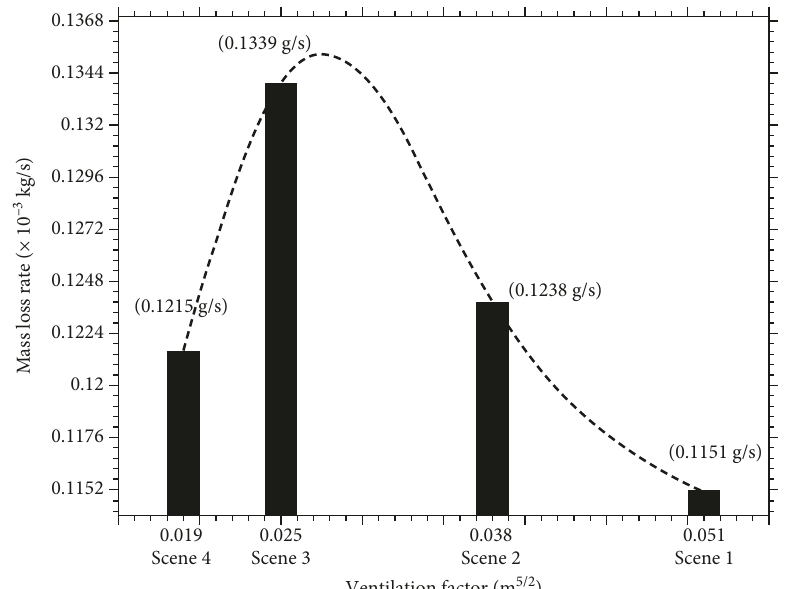
Figure 6: Histogram of the variation of the mass loss rate of fuel over ventilation factor.